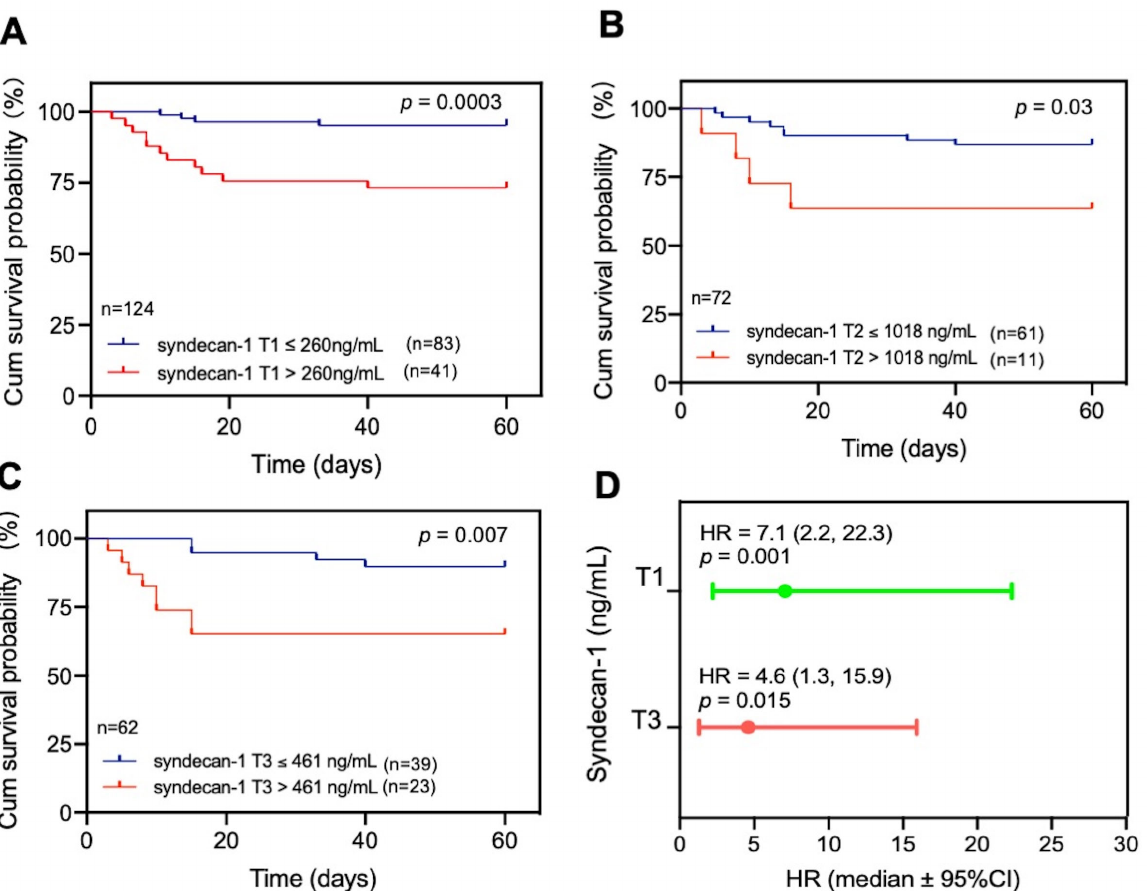
Figure 2. Elevated plasma levels of syndecan ‐ 1 in COVID ‐ 19 patients are associated with the 60 ‐ day mortality rate. Kaplan–Meier survival analysis determined the survival rates in COVID ‐ 19 patients with plasma levels of syndecan ‐ 1 >260 ng/mL vs. ≤ 260 ng/mL at T1 ( A ), >1018 ng/mL vs. ≤ 1018 ng/mL at T2 ( B ), and >461 ng/mL vs. ≤ 461 ng/mL at T3 ( C ). Cox hazard proportional regress analysis determined the hazard ratios (HR) of having increased levels of plasma syndecan ‐ 1 at >75 percentile at T1 and T3 ( D ).